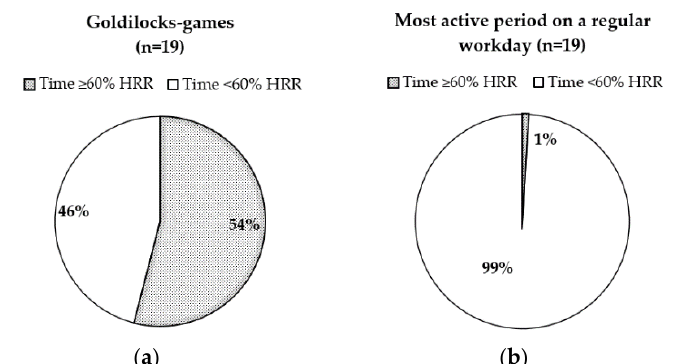
Figure 5. Compositions (geometric means) of time (in terms of percent) spent with and without HIPA, ( a ) during the Goldilocks-games, ( b ) during the regular workday period. Abbreviations: HRR, heart rate reserve.